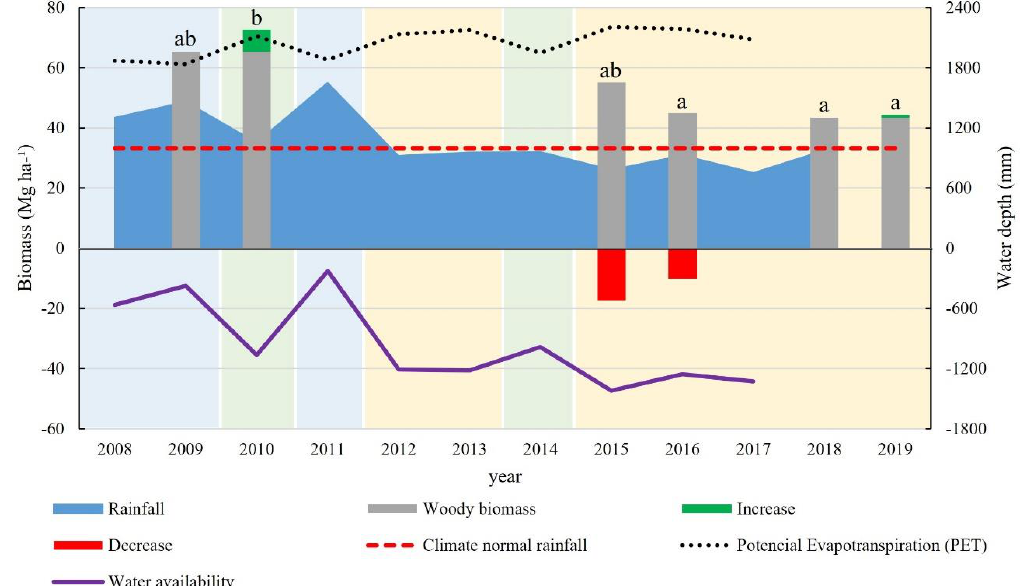
Figure 7. Annual distribution of above-ground woody biomass and rainfall in a fragment of dry forest, Iguatu-Ceará. The same lowercase letters between years do not differ by the Friedman test ( p ≤ 0.05).